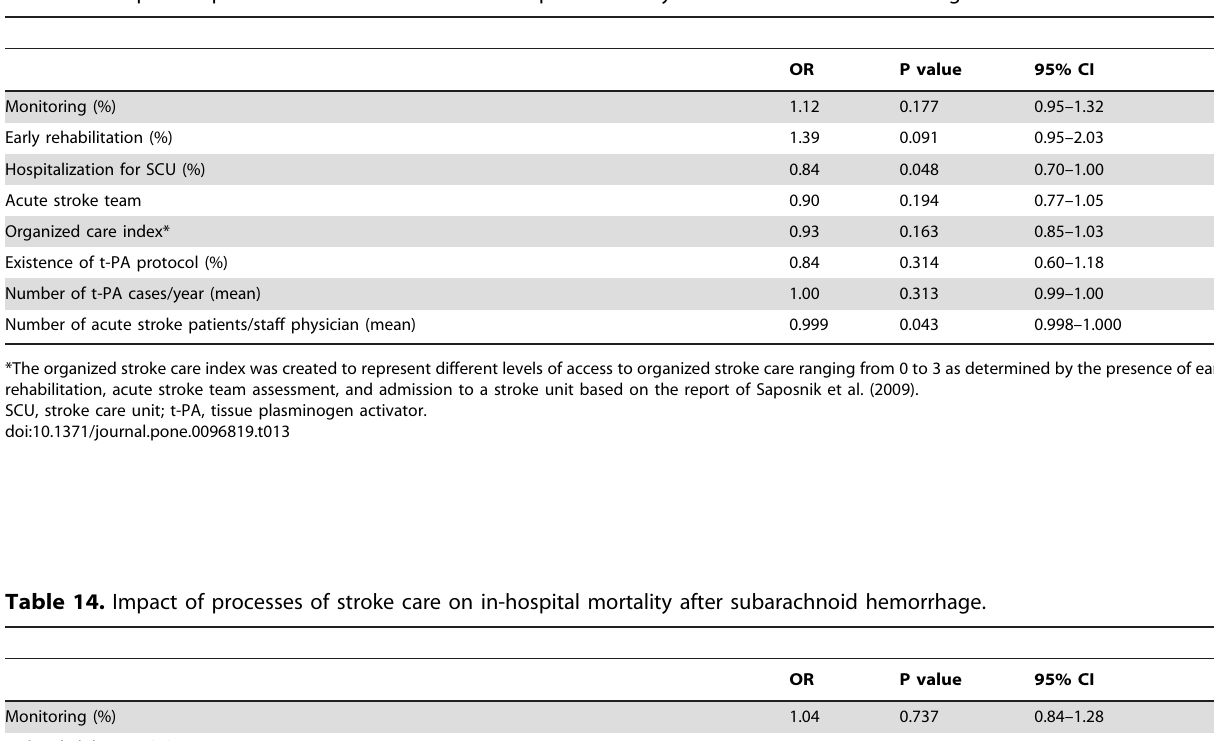
Table 13. Impact of processes of stroke care on in-hospital mortality after intracerebral hemorrhage.